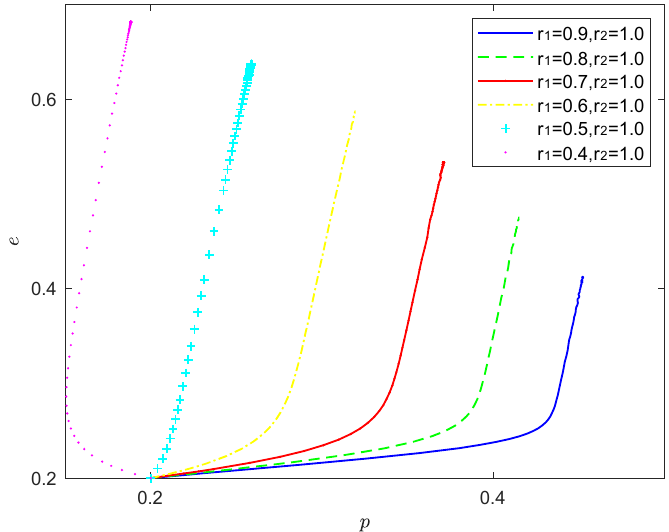
Figure 8. Evolution of game strategy in (optimistic, rational) state.